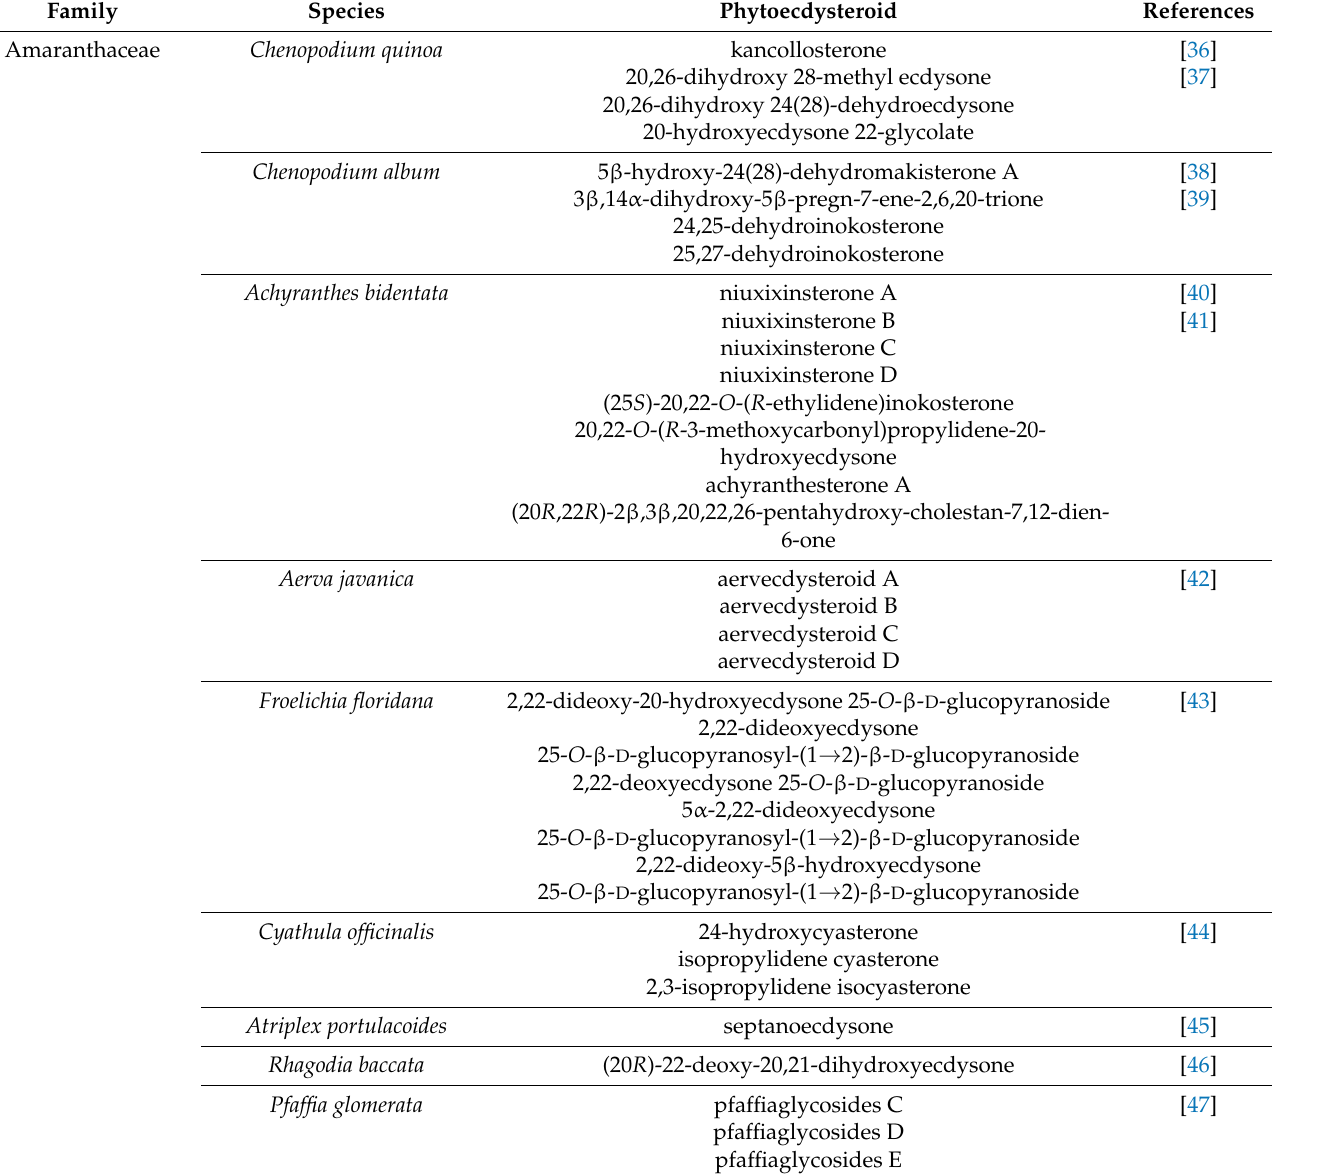
Table 1. Distribution of phytoecdysteroids in selected plant